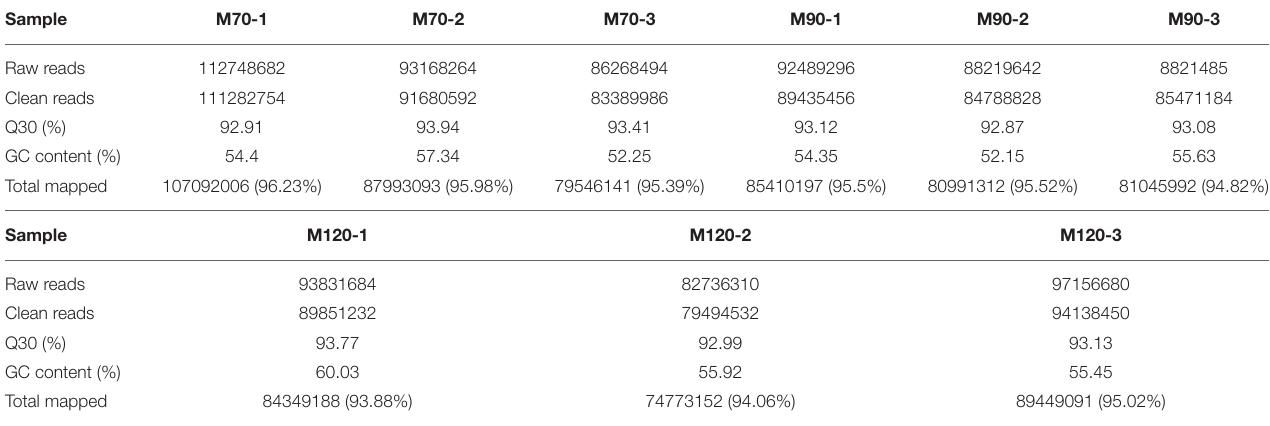
TABLE 1 | Summary of clean reads mapped to the Capra hircus reference